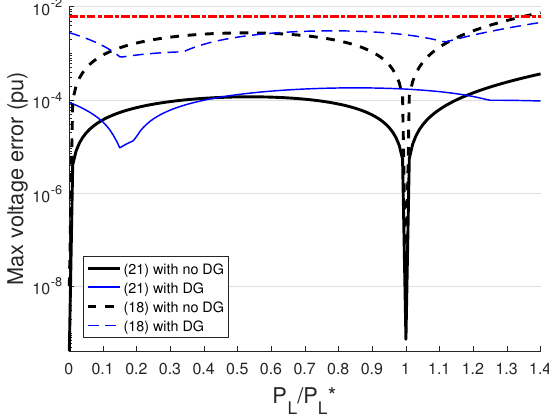
Figure 14. The 123-bus grid voltage error for both the models in Equation (21) and Equation (18), with S l =